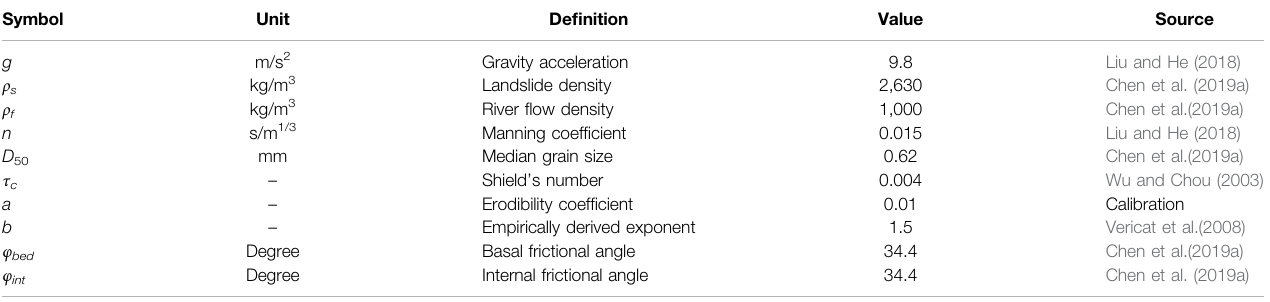
TABLE 1 | Model parameter values used in numerical simulations of landslide dam formation. Symbol